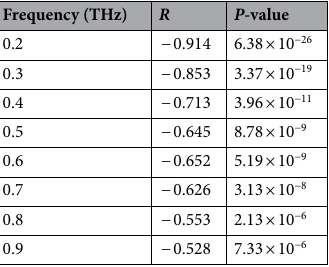
coefficients and the concentrations of TG in the blood have a linear relationship: α = 116.72 − 4.13 C TG − 3.21 C RBC , where C corresponds to the concentrations of certain human blood components. This linear correlation indicates